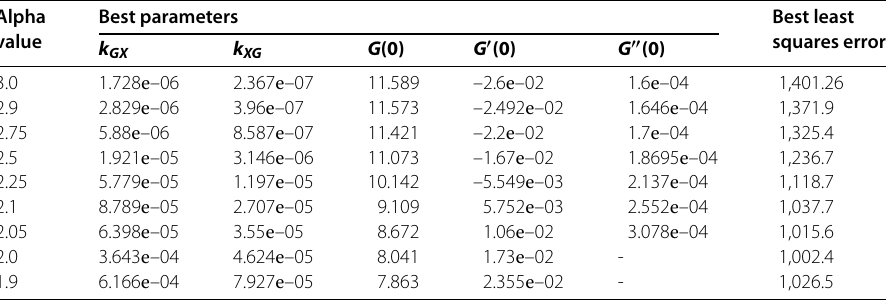
Table 2 Best least squares fits for fractional alpha model for subject 2 CGM data Alpha value